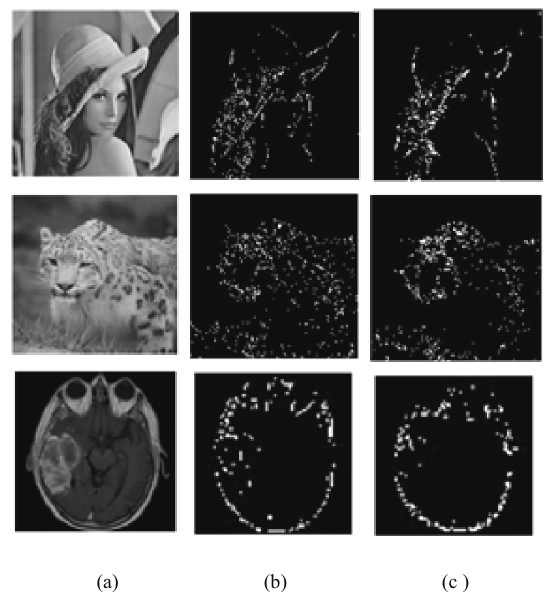
Figure 4: Examples of feature point maps (a) Original images (b) Proposed feature point maps (c ) Wavelet representation